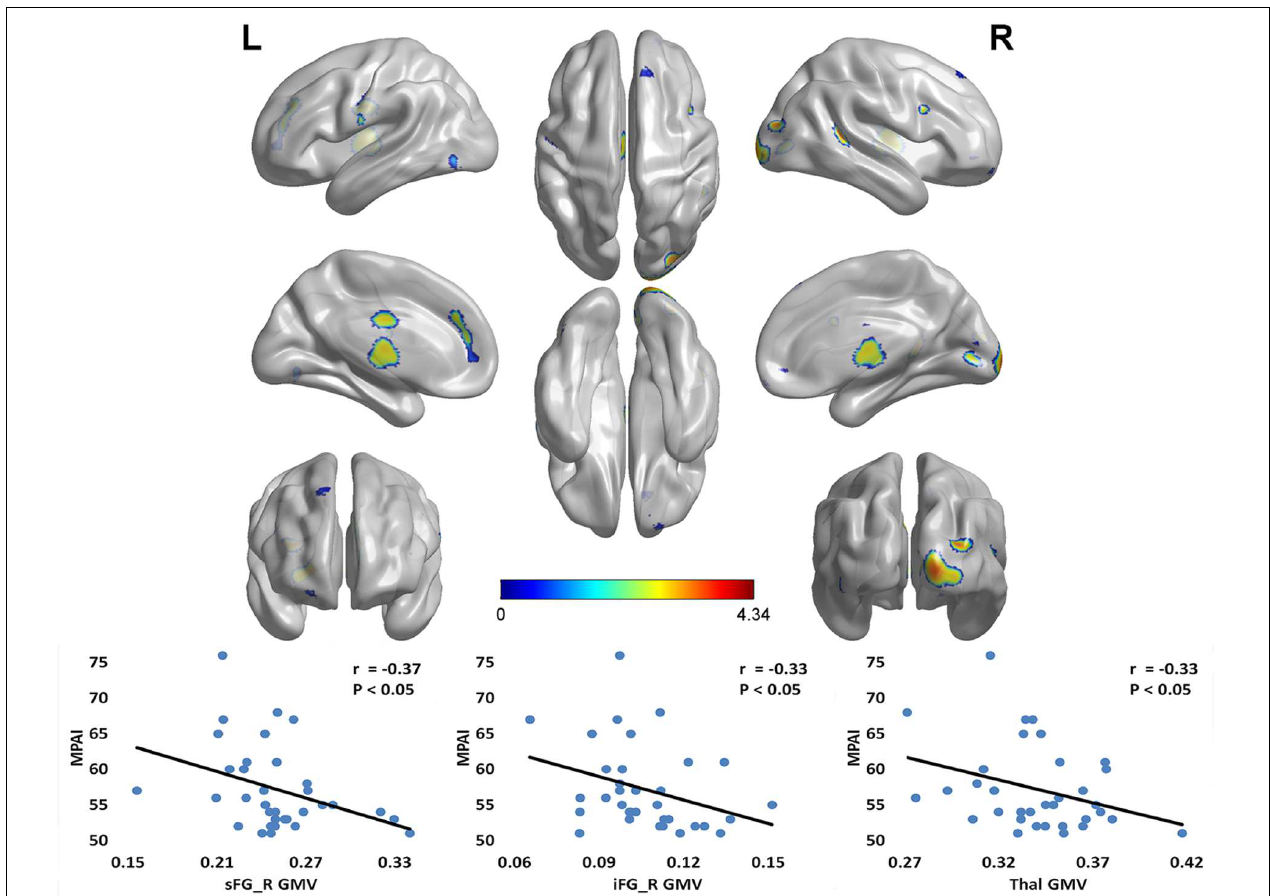
FIGURE 1 | Notable GMV differences between MPD group and control group (CG > MPD), and the negative correlation between GMV and MPAI scores within MPD group. Compared with the control group, the MPD group had remarkably decreased GMV in the right sFG, right iFG, bilateral mFG, right mOG, left ACC, and bilateral Thal. Furthermore, within the MPD group, the GMV of the right sFG, right iFG and Thal was negatively correlated with MPAI scores. sFG, superior frontal gyrus; iFG, inferior frontal gyrus; mFG, medial frontal gyrus; mOG, middle occipital gyrus; ACC, anterior cingulate cortex; Thal, thalamus; MPD, mobile phone dependency; CG, control group; MPAI, Mobile Phone Addiction Index; GMV, gray matter volume. L, left; R,